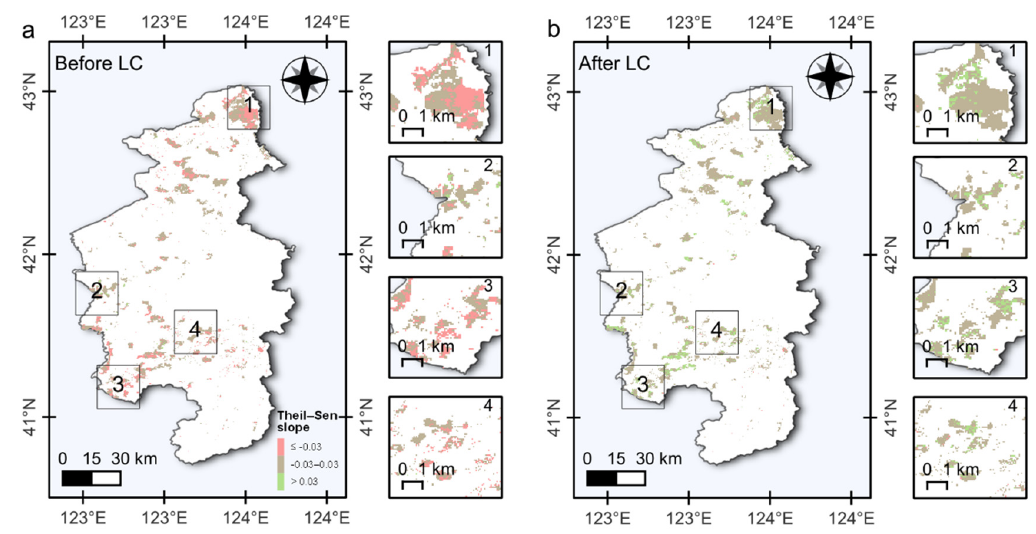
Figure 8. The trend strength of the EEQ (Theil–Sen slope value) in the FC areas at the 95% confidence level before FC ( a ) and after FC ( b ); the subsets (1–4) are used to reflect the changes.